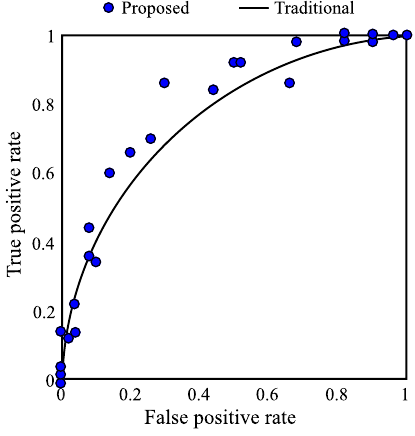
Figure 11. ROC of the algorithm.